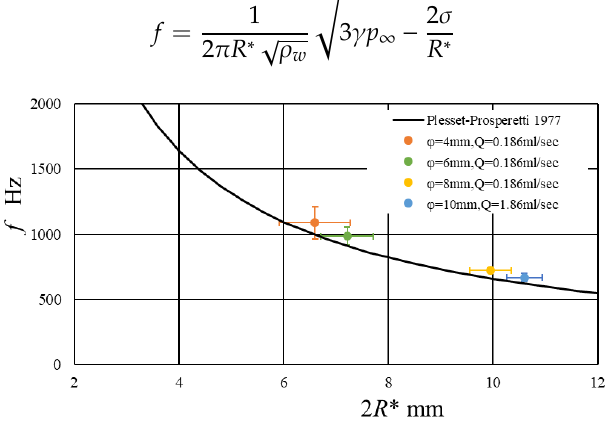
Figure 3. Relation of primary frequency with bubble diameter.